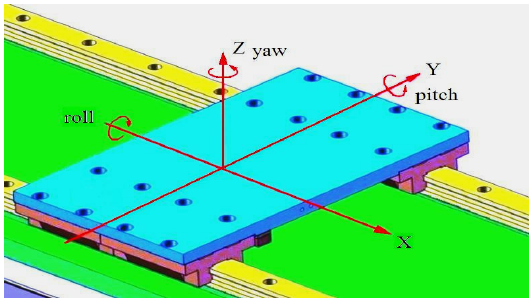
Figure 3. Degrees of freedom (DOFs) of the stage.